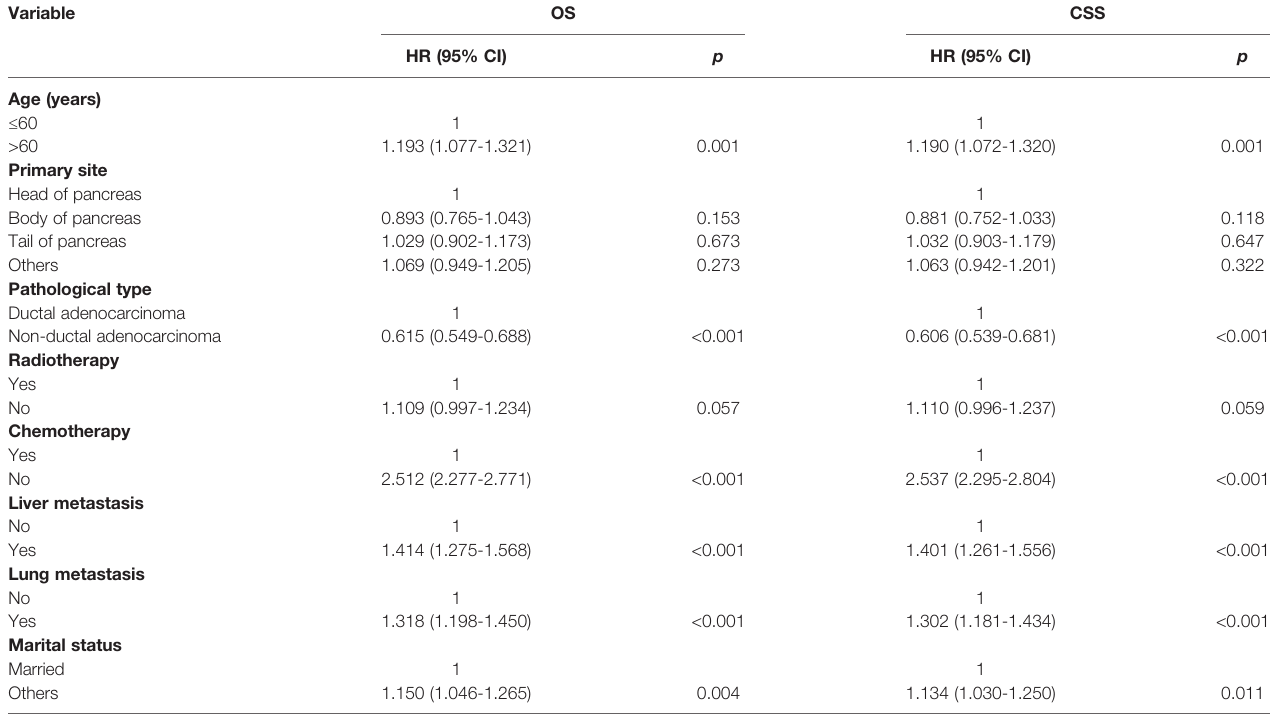
TABLE 3 | Multivariate Cox analysis of variables in pancreatic carcinoma bone metastasis. Variable